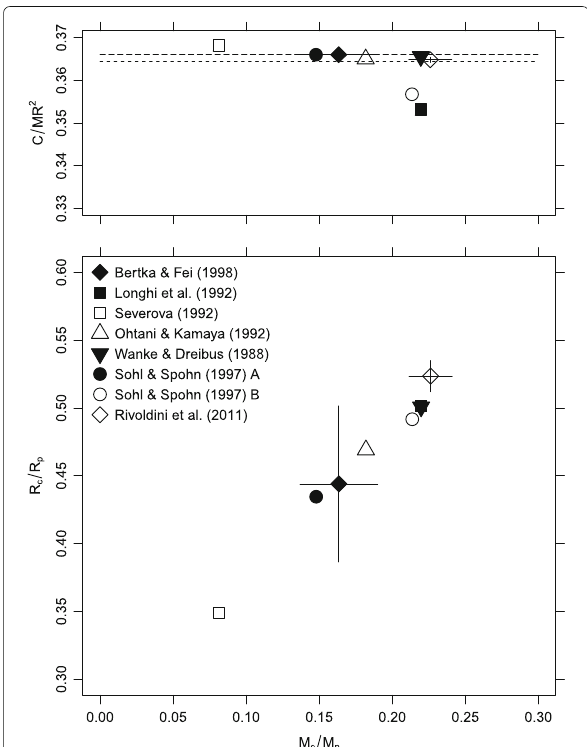
Fig. 2 Dependence of internal properties on compositional models for Mars. Top panel shows polar moment of inertia C / Mr 2 for each of seven models, characterized by their fraction of core mass to total planetary mass M c / M p . Bottom panel shows core radius as a fraction of planetary radius for each compositional model. Horizontal lines in upper panel are upper limit for C / Mr 2 (Esposito et al. 1992) and its recently determined value from the Mars Reconnaissance Orbiter mission (Konopliv et al.